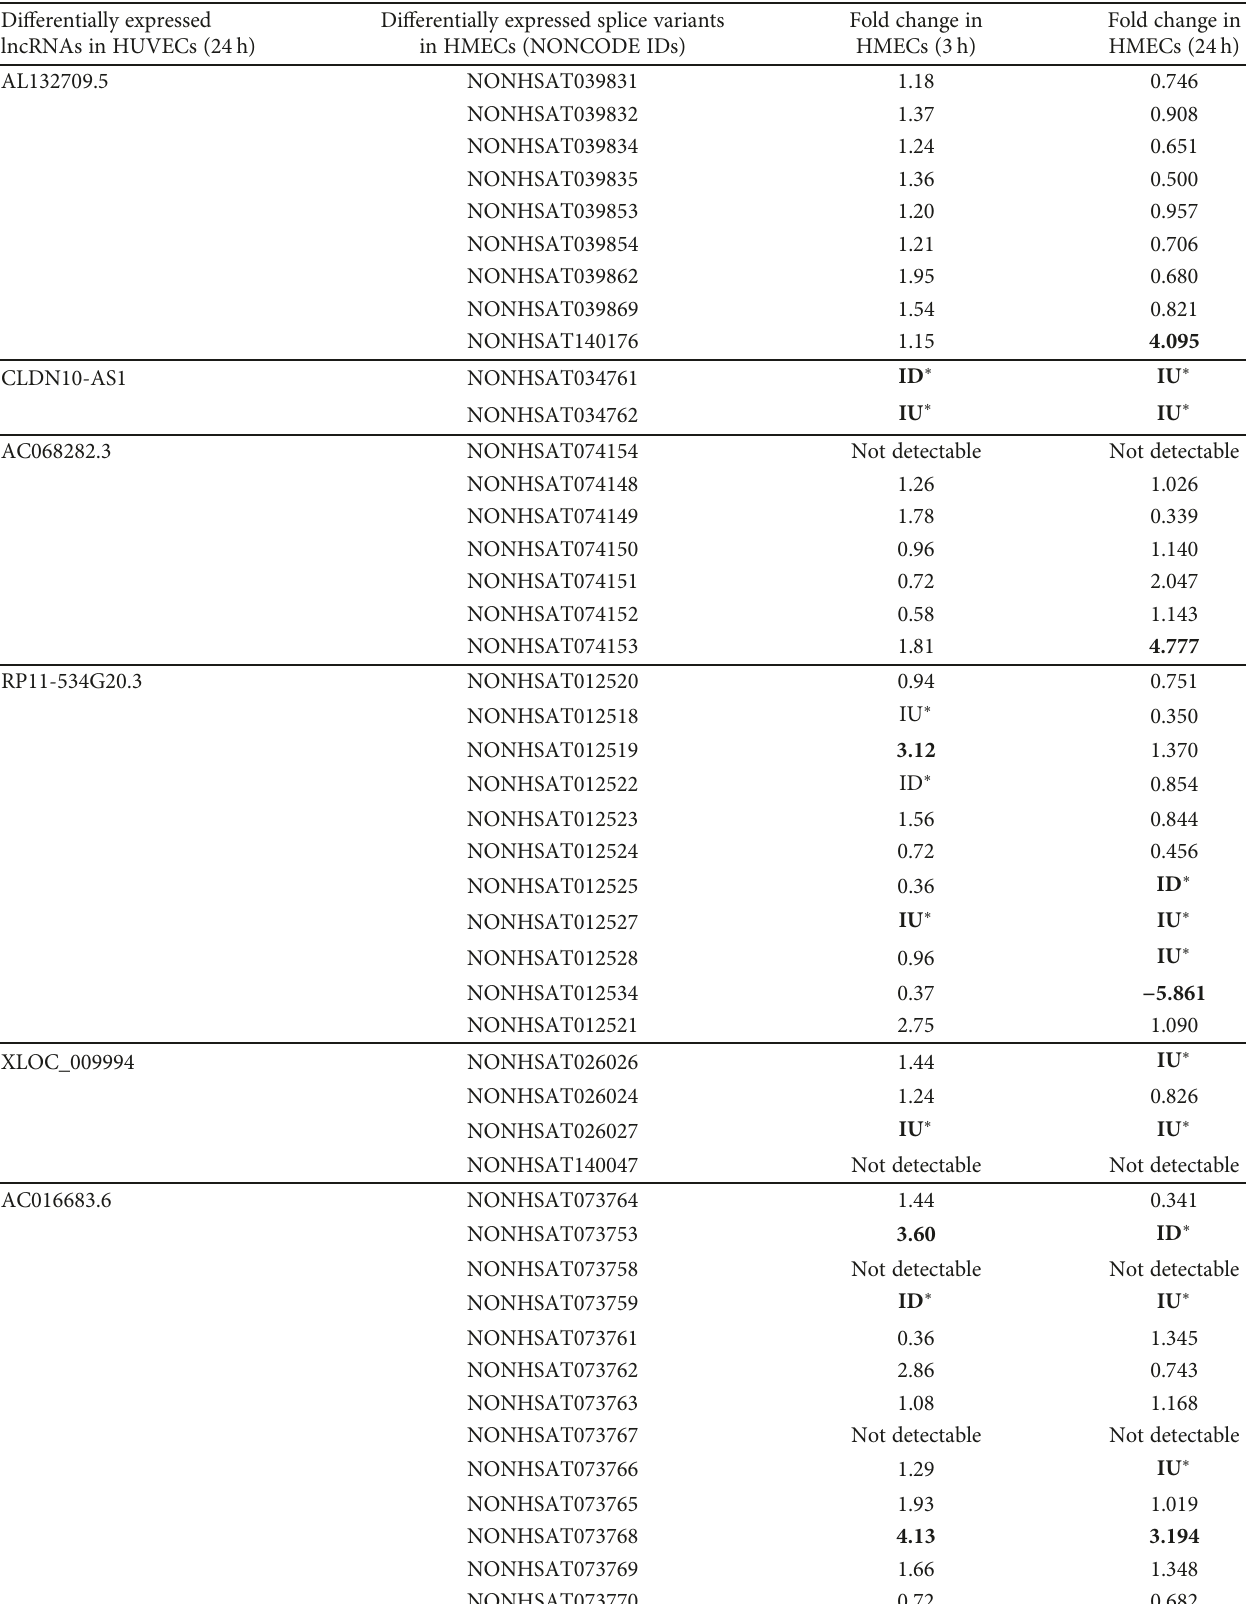
Table 3: Comparison of lncRNAs di ff erentially expressed during LPS treatment in HUVECs [22] and HMECs. Di ff erentially